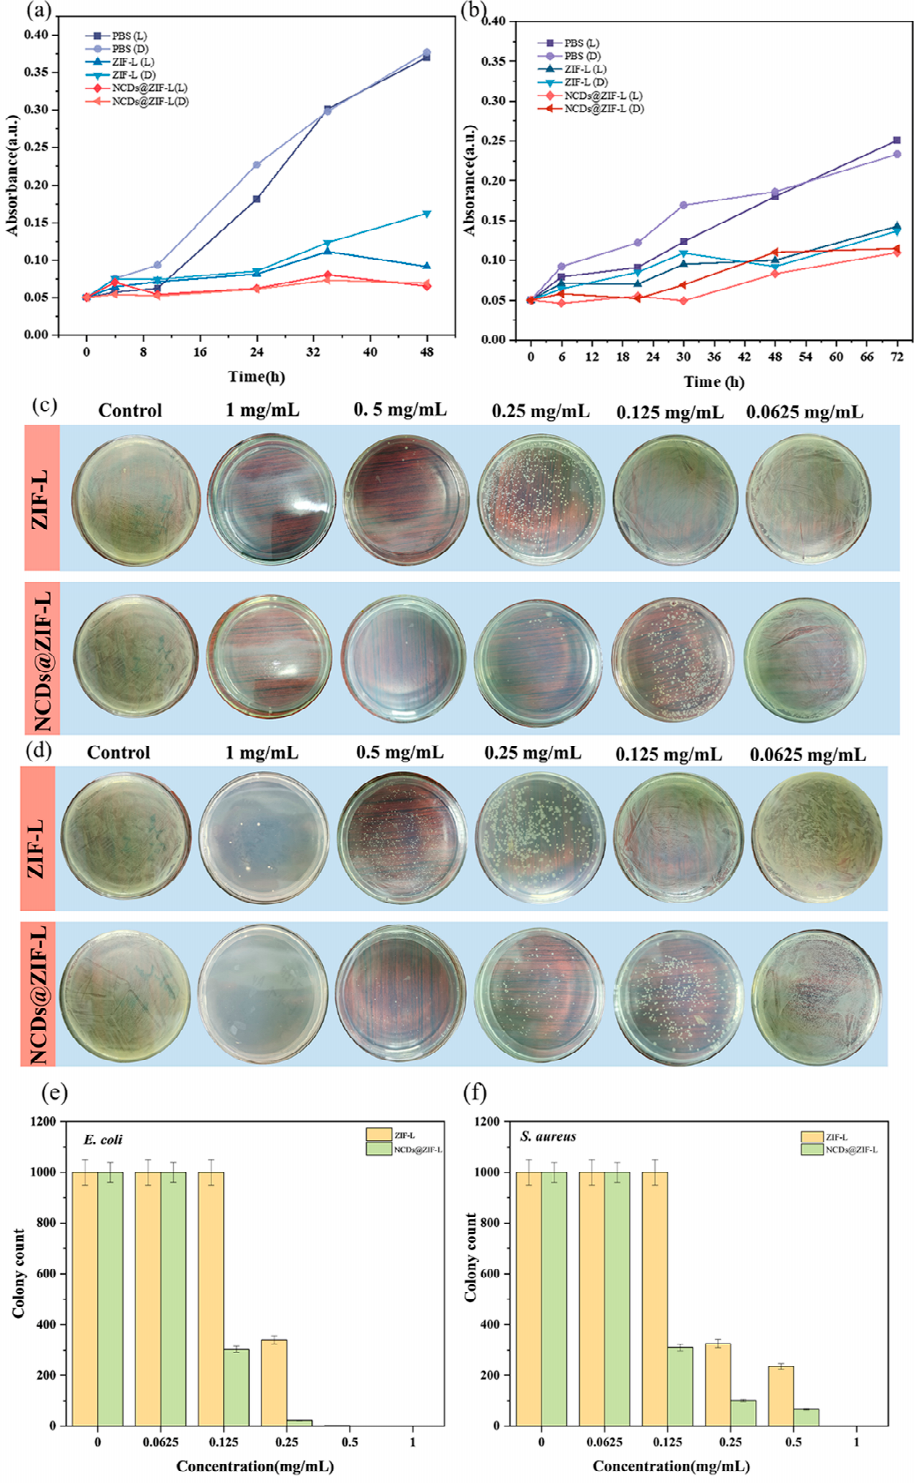
Figure 5. Antibacterial test results. The OD 600 method measures the antibacterial performance of the material against ( a ) E. coli and ( b ) S. aureus at different times. Bacterial survival of E. coli ( c ) and S. aureus ( d ) after treatment with materials of different concentrations. Colony count after material treatment: E. coli ( e ) and S. aureus ( f ).